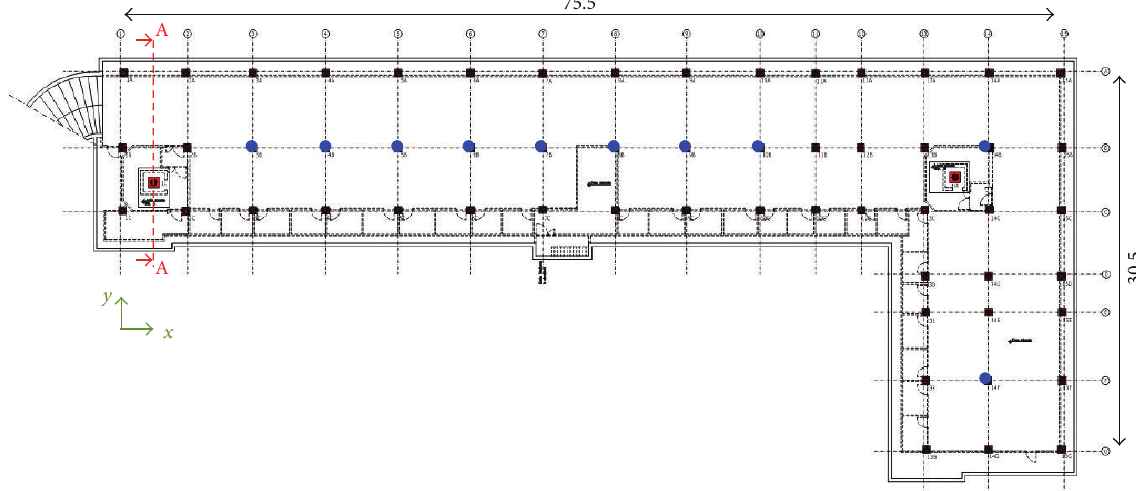
Figure 1: Basement plan of the building highlighting the positions of all 59 DFP isolators (squares: A-type; circles: B-type).